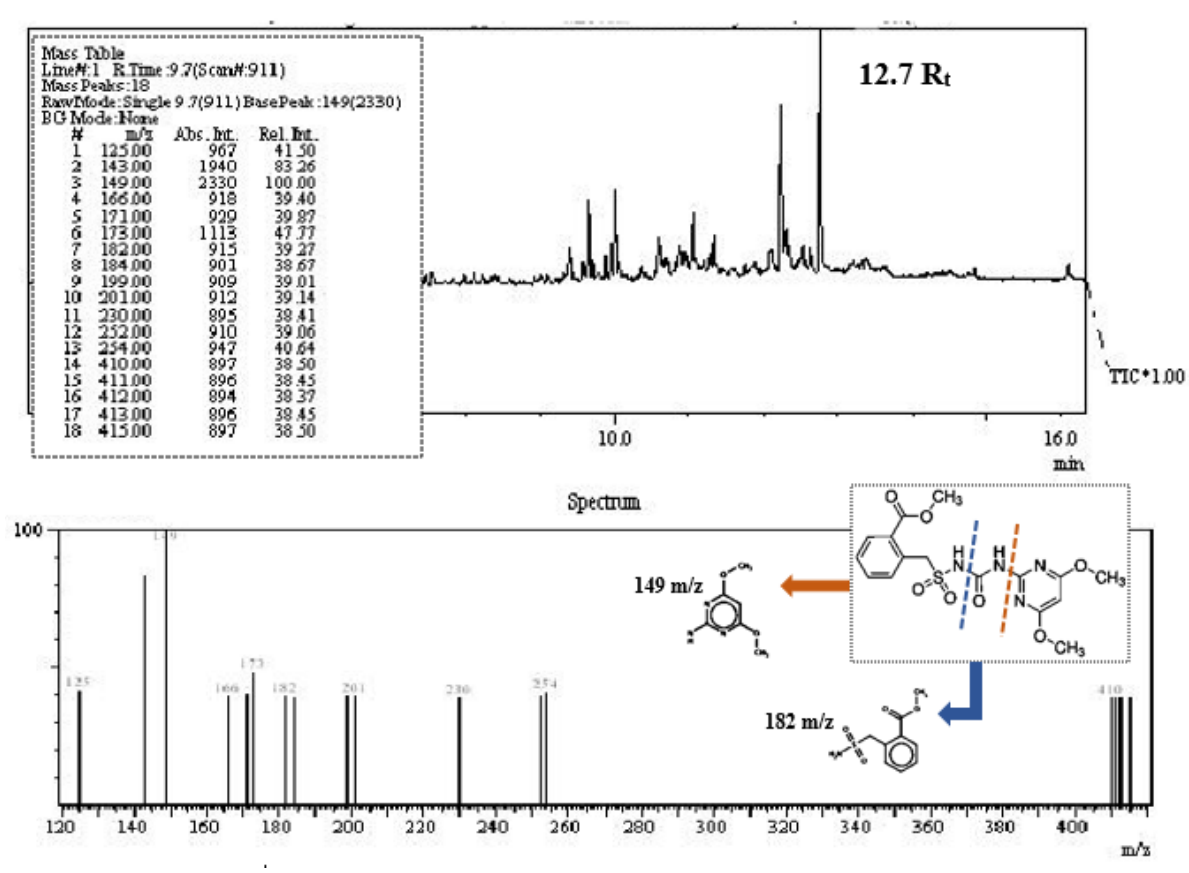
. Inset: Mass table of BSM metabolites. An m/z spectrum with t